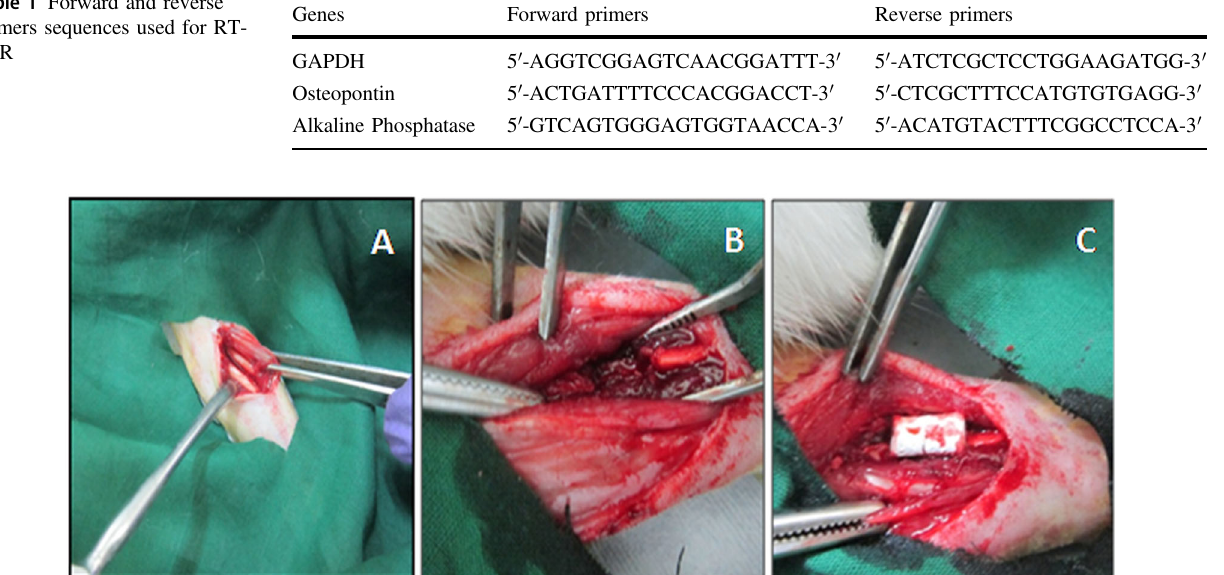
Fig. 1 Implantation of microsphere sintered scaffold in rabbit ulnar model. A The radial and ulnar bones were exposed. B 10 mm defect in ulnar bone. C Scaffold implanted at the defect site